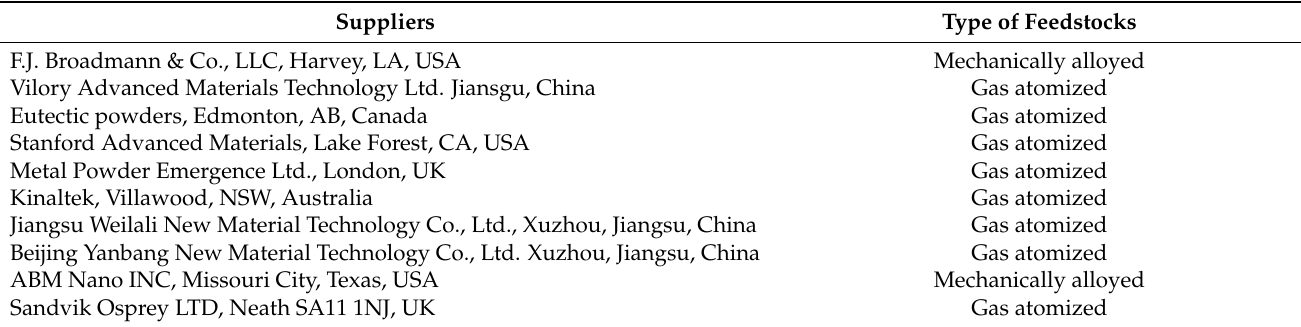
Table 1. The list of suppliers that provide high-entropy alloy